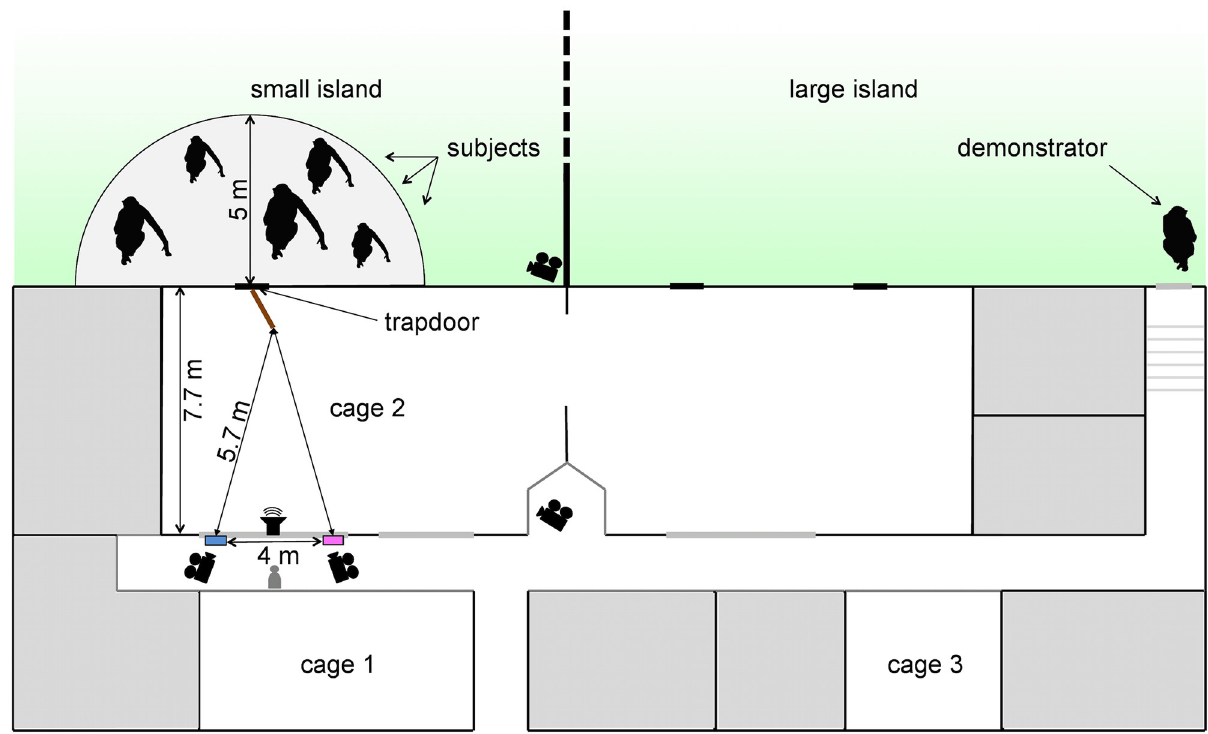
Fig 1. Layout of indoor and outdoor enclosures for the three experimental phases. Phase 1 –observational learning : demonstrators (KEL, DW) were held individually in cage 1 (demonstration room) and given a choice of pink and blue chow. Subjects were able to observe this process from across the corridor in cage 2 (observation room). Phase 2 –foraging training : blue or pink chow was provided to the subjects in one of two adjacent food troughs, 4 metres apart and equidistant from the point of entry (trapdoor). Phase 3 –playback experiment : a loudspeaker was placed at midpoint between the two food troughs. The demonstrator whose calls were to be played back was lured away to the large island so as to be out of earshot, while subjects were required to be on the small island within 5 metres of the trapdoor. During each trial, the experimenter (GS) positioned herself at midpoint between the two troughs to document the subjects’ foraging